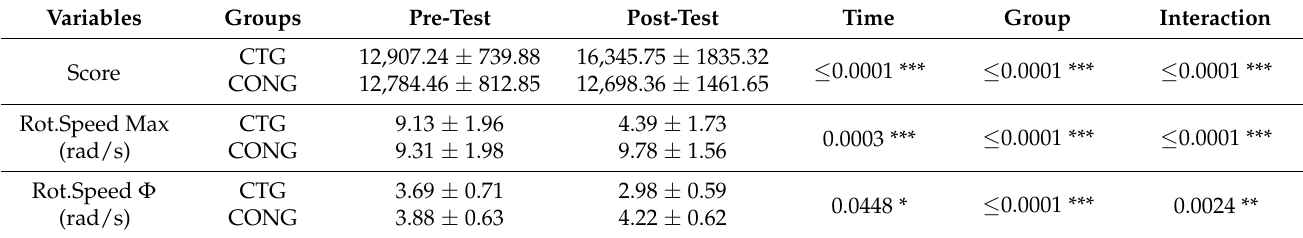
Table 4. Comparative analysis of various indicators of dynamic balance ability before and after the experiment.